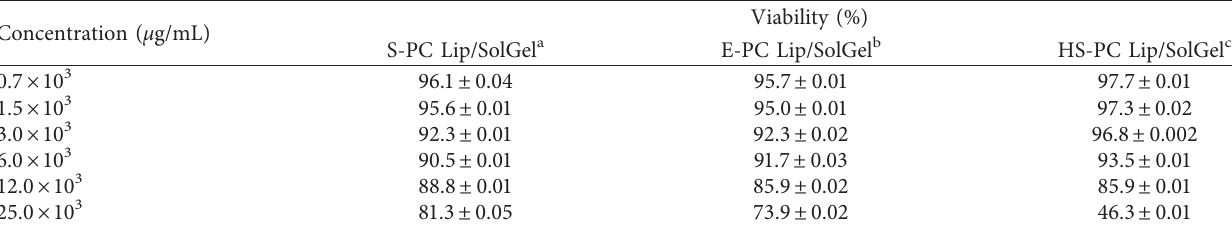
Figure 5: DTA thermograms of CUR-loaded liposomal solid gel formulations. Samples were scanned within a range of 30 to 250 ° C, at a heating rate of 10 ° C/min. E-PC Lip/SolGel, egg-phosphatidylcholine liposomal solid gel; S-PC Lip/SolGel, soy-phosphatidylcholine li- posomal solid gel; HS-PC Lip/SolGel, hydrogenated-soy-phosphatidylcholine liposomal solid gel; PM, the physical mixture of each Table 1: Cell cytotoxicity (CC 50 ) of CUR-loaded liposomal solid gels, determined by the incubation of a series of sample concentrations to reach 50% of cells that remain viable.